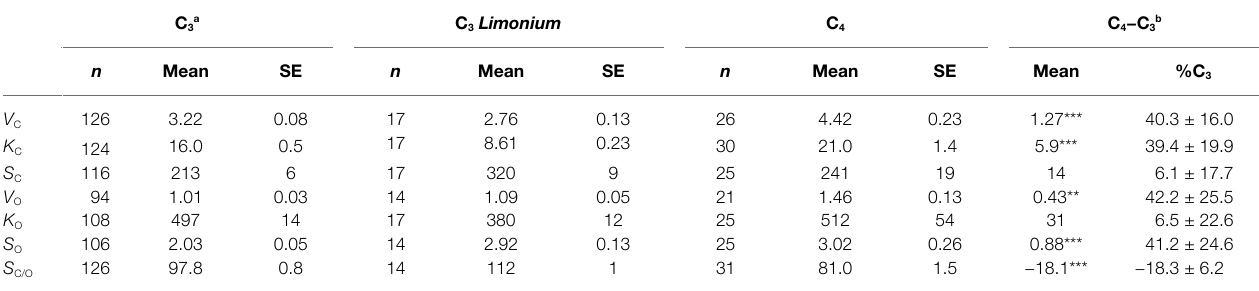
TABLE 1 | Sample sizes ( n ) and mean values of RuBisCO kinetic parameters: maximum turnover rates, V max (s −1 ), Michaelis constants, K M (μM), and specificities, S = V max / K M (s −1 .mM −1 ) and relative specificities S C/O with standard errors in the means (SE) for C 3 , C 3 Limonium , and C 4